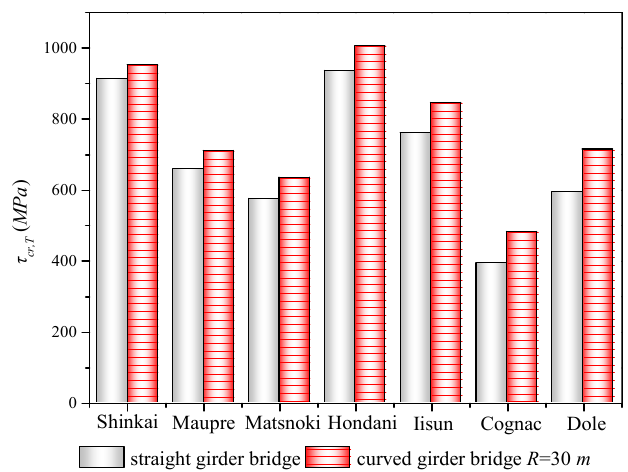
Figure 14. Comparison of global shear buckling strength of a corrugated web used in a straight bridge ( R = ∞ ) and a curved bridge ( R = 110 m). Table 7. Global elastic shear buckling strength of PCCSW with varying curvature